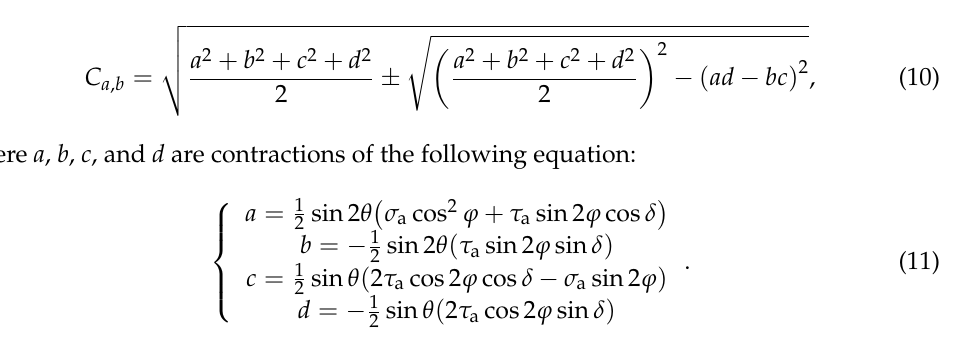
Figure 4. Spherical coordinates employed to define material plane.